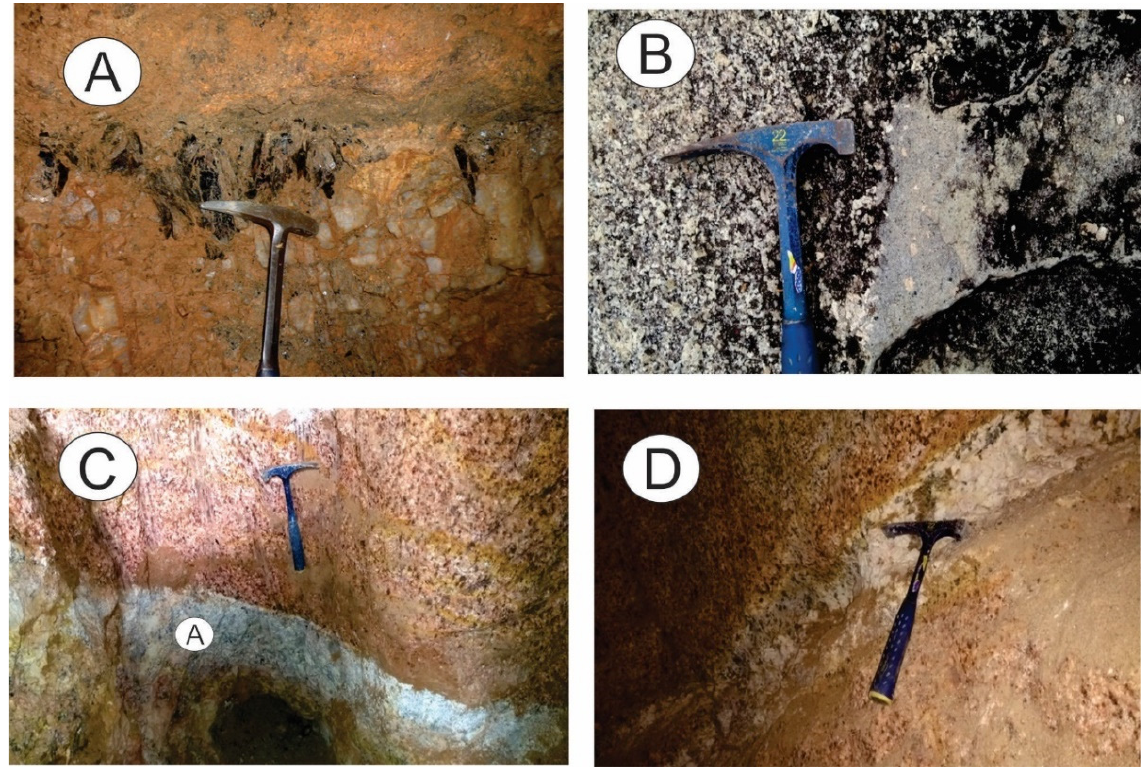
Figure 14. Macroscopic aspect of the exogreisens that make up the São Domingos Region. ( A ) Detail of the pegmatitic vein composed of K-feldspar, quartz, cassiterite, and zinnwaldite; ( B ) photomicrograph of exogreisens intercalated with a vein of quartz with cassiterite; and ( C ) contact between the quartz vein with cassiterite and; ( D ) the greisen zone with zinnwaldite development.